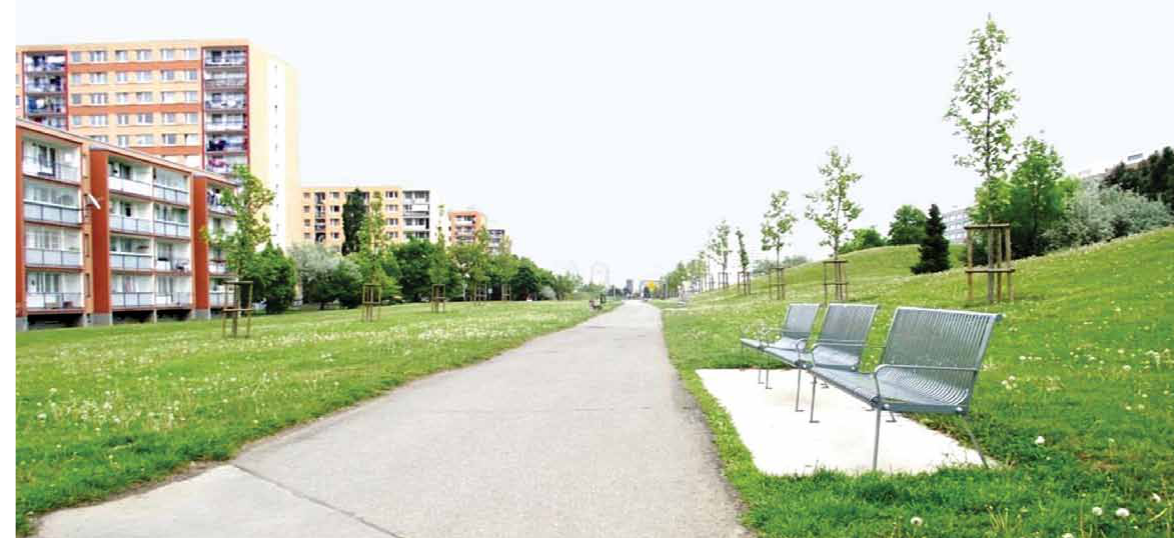
fig. 5. The main “promenade” of the Central